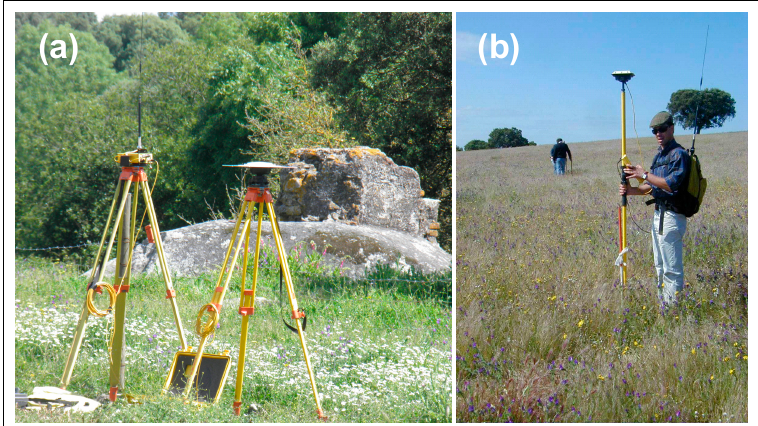
Figure 3. Trimble RTK/PP-4700 GPS: ( a ) station and radio; ( b ) rover.